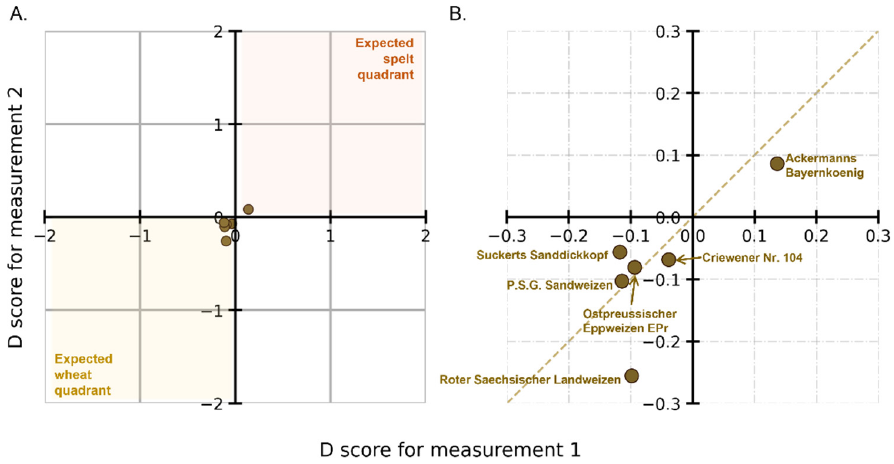
Figure 5. Youden plot showing the D scores for old wheat cultivars ( A ) with the magnified section in ( B ). The cultivars (brown circles) are shown to be not unambiguously classified as spelt or wheat.